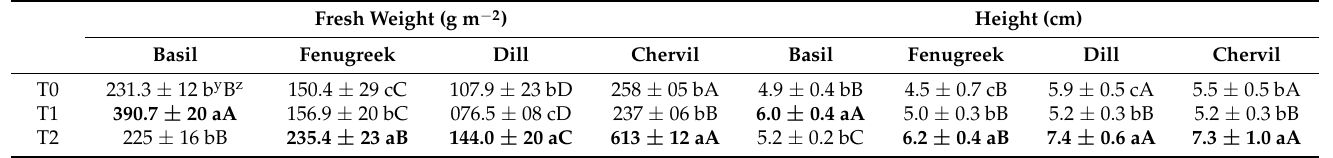
Table 2. Fresh weight (g m − 2 ) and height (cm) of basil, fenugreek, dill, and chervil microgreens cultivated under three light-emitting diode (LED) treatments. The best light treatment, for each plant species, is